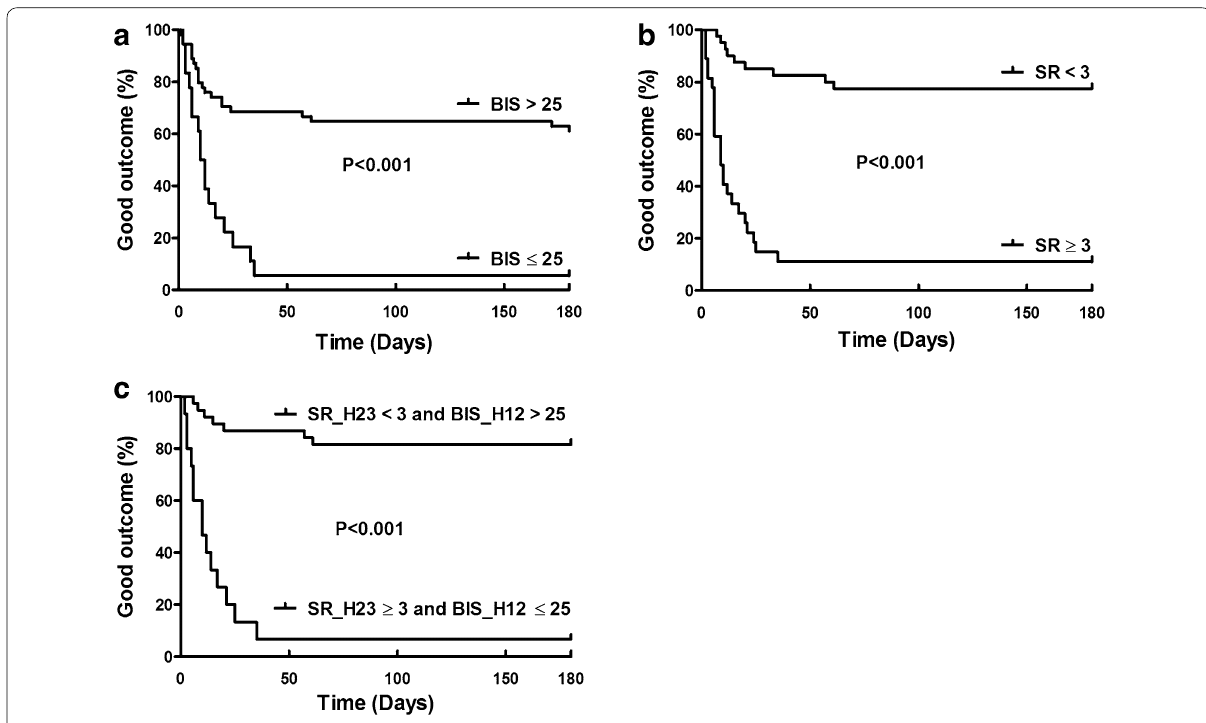
Fig. 4 Survival analyses. Kaplan–Meier curves showing survival with a good neurological outcome according to BIS monitoring at hour 12 ( a ), SR monitoring at hour 23 ( b ) or both ( c